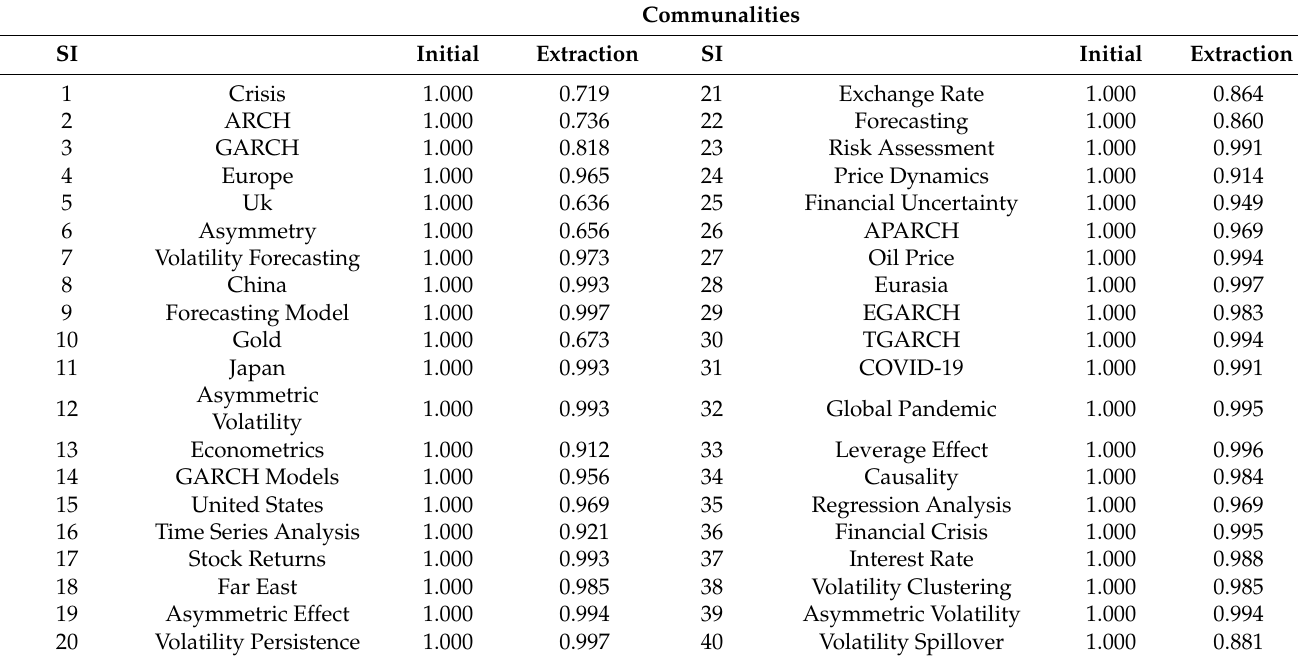
Table 6. Communalities of asymmetric GARCH models themes.